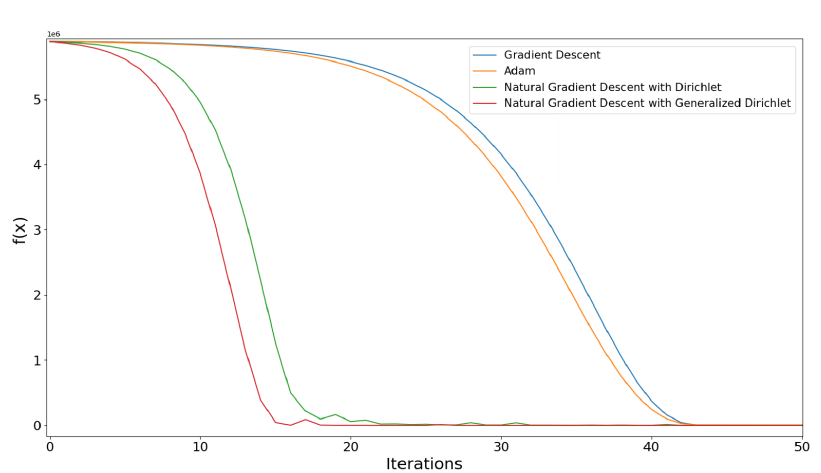
Figure 2. The rate of convergence on generalized Rosenbrock function using various algorithms.